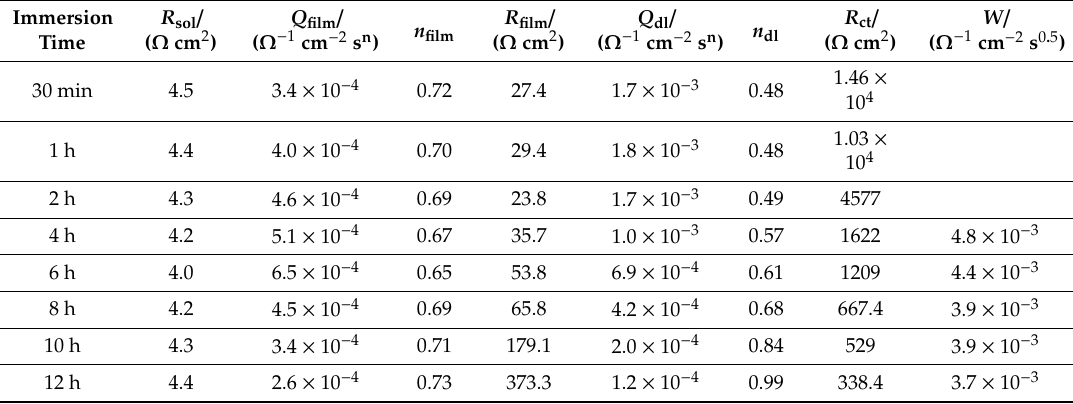
Table 1. Calculated parameters for equivalent circuit components in Figure